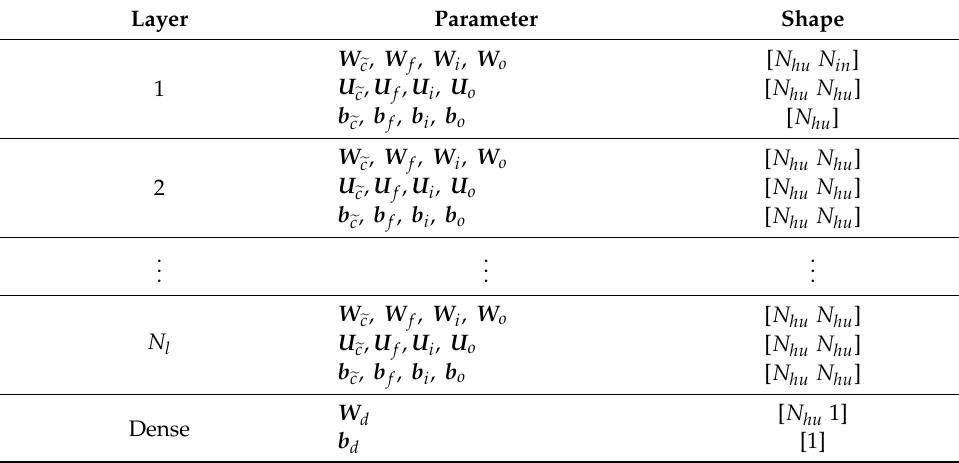
Table 2. Learnable parameters of each layer of LSTM and their